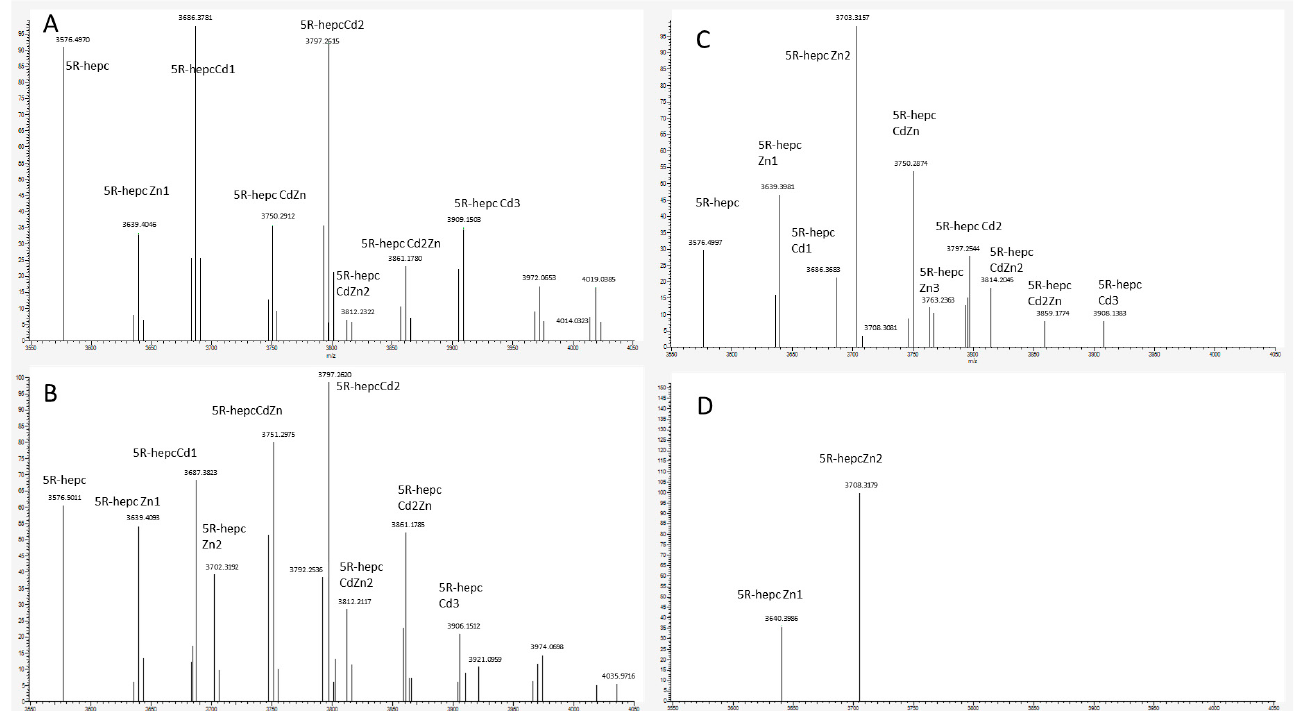
Figure 7. Deconvoluted Native MS spectra of 10 μM 5R - hepcidin and 20 μM Cd(II) acetate with the following concentrations of Zn 7 MT2A: ( A ) 1 μM, ( B ) 3 μM, ( C ) 10 μM, ( D ) 30 μM in ammonium acetate pH 7.4.